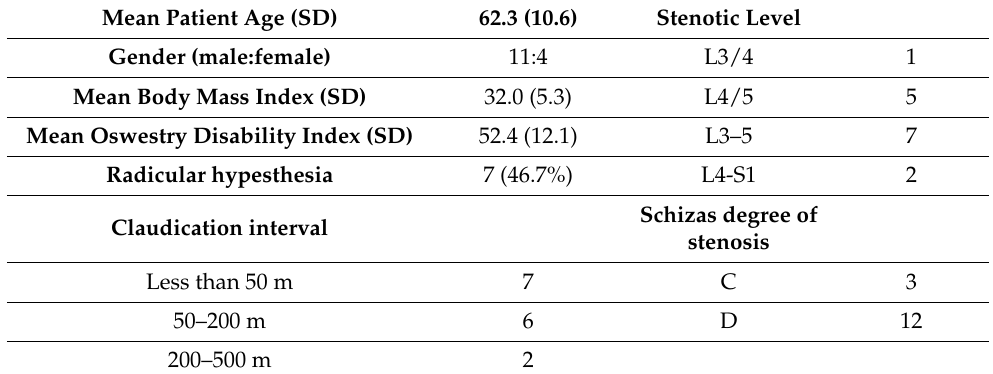
Table 4. Patient characteristics ( n =